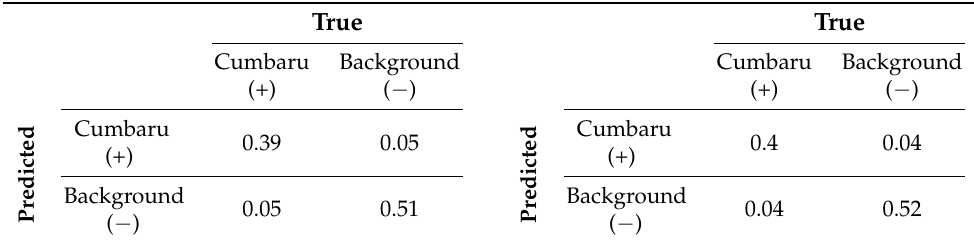
Table A2. Confusion matrix for the SegNet without CRF (left) and with CRF (right). The values are normalized by the total of pixels.